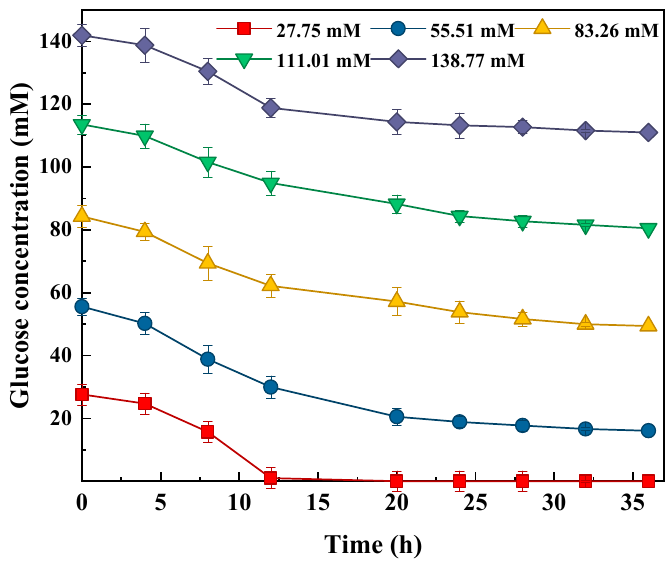
Figure 4. Residue glucose concentration during bio-hydrogen production at varying glucose concentrations.